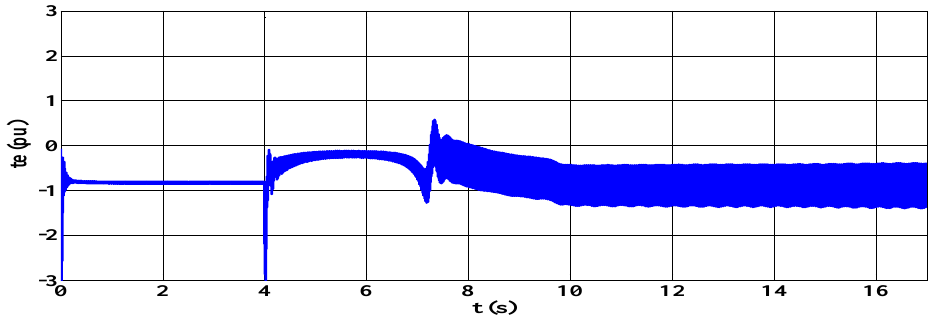
Figure 16. Electromagnetic torque (short-circuit happens at t = 4